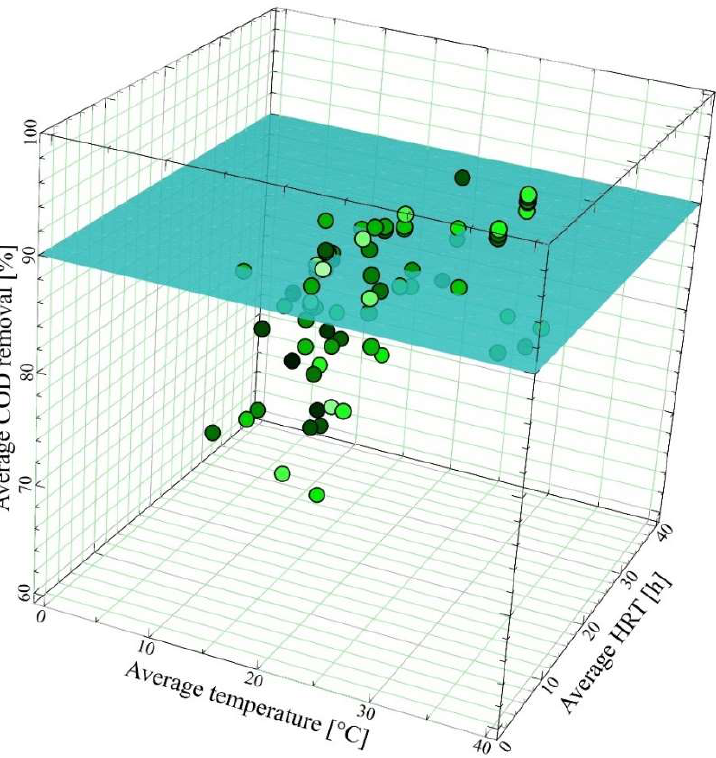
Figure 5. The impact of average temperature and HRT on the average COD removal during treatment of real and synthetic municipal wastewaters in AnMBRs. Results presented in [70,75,115,120,123,149–154,156,157,161,162,171,172,174,177–179].